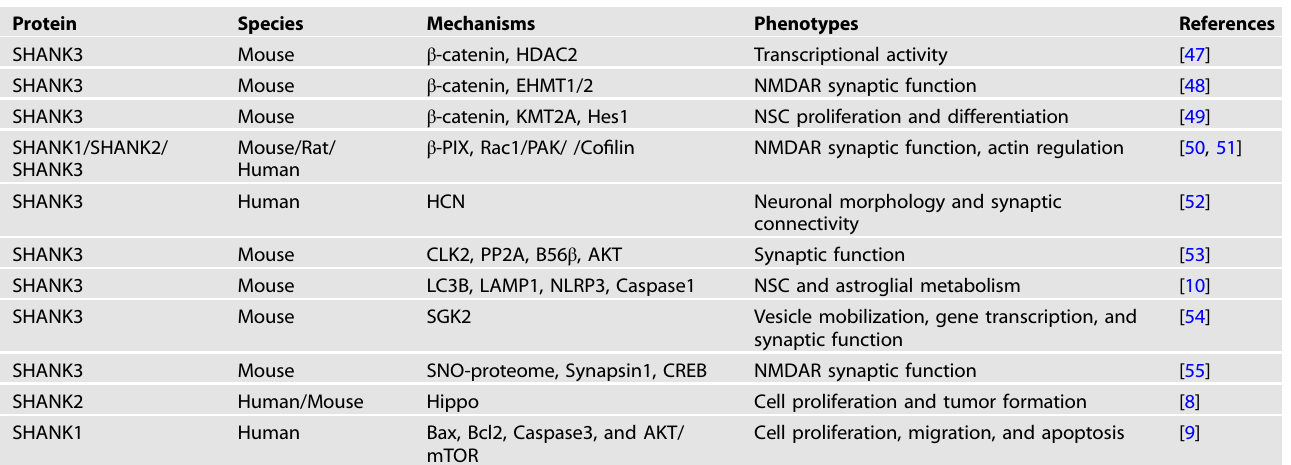
Table 1. Signaling pathways regulation by the SHANK family. Protein